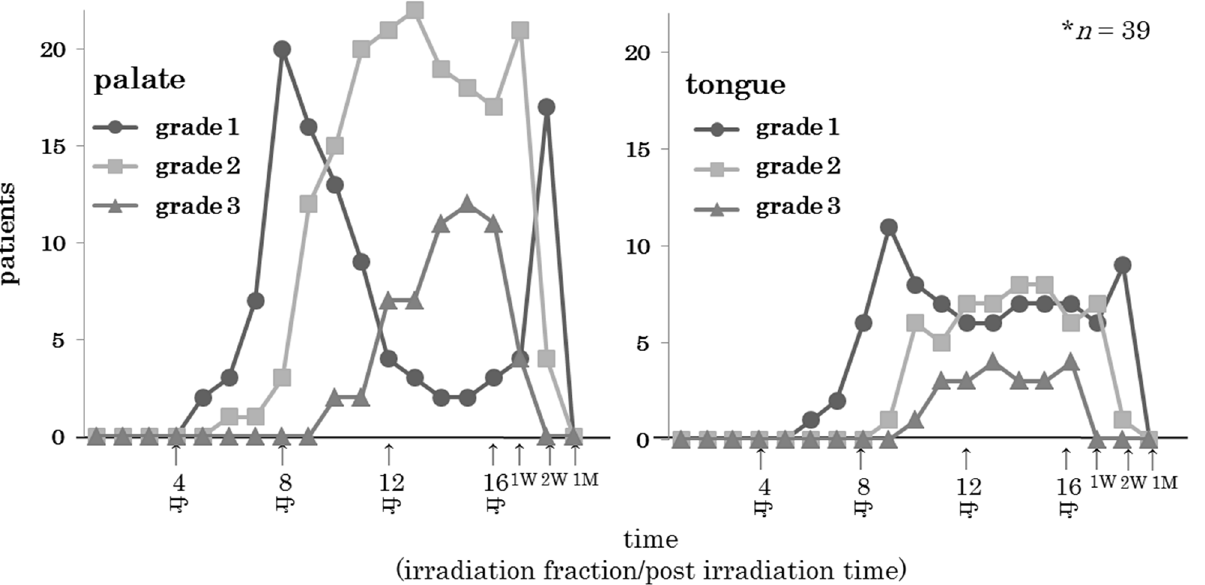
Fig 5. Temporal pattern of acute radiation mucositis (ARM) of the palate or tongue. We assessed the change in ARM over time. The times are indicated as fractions 1 to 16, and 1 or 2 weeks and 1 month post irradiation.